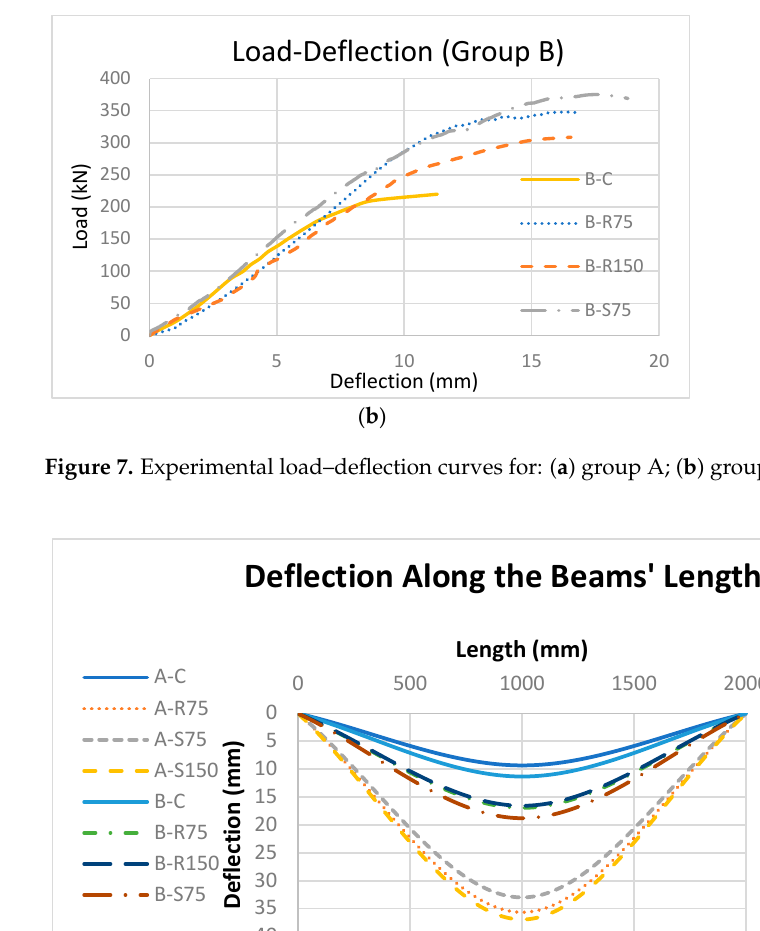
Figure 7. Experimental load–deflection curves for: ( a ) group A; ( b ) group B.